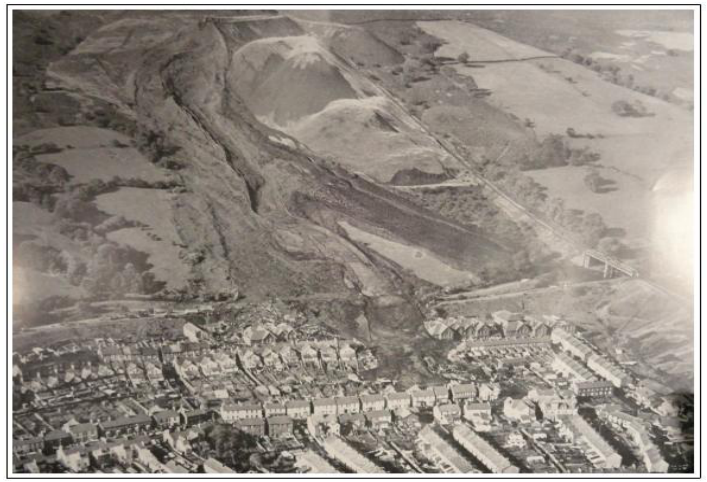
Figure 5. Photograph of the Aberfan disaster (from UK National Archive). Table 1. Aberfan flowslide characteristics.